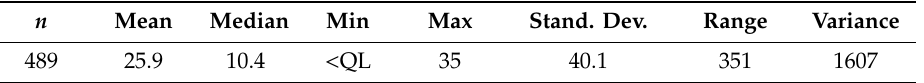
Table 2. Basic statistics for mercury results obtained for all tested samples ( n = 489) ( µ g / kg).